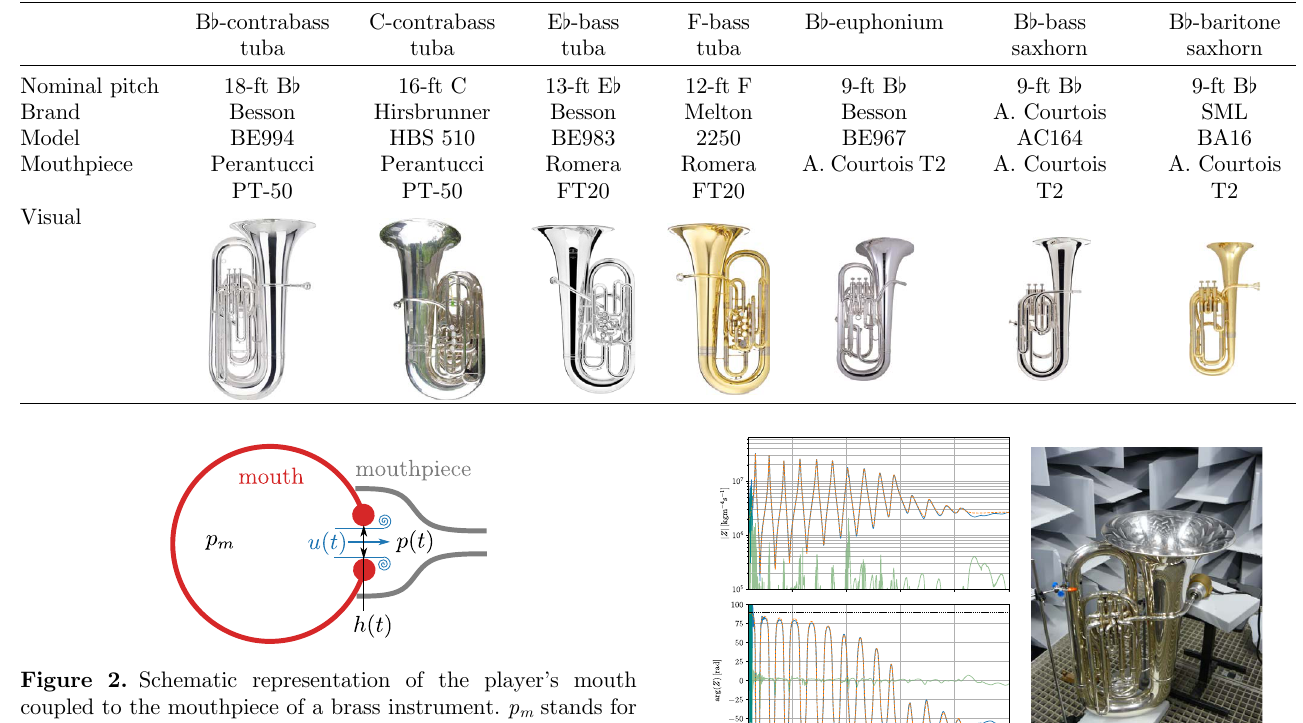
Table 1. Characteristics of the seven tubas studied in this paper, classi fi ed in the same order as in Figure 1. By convention, the nominal pitch speci fi es a number of feet (ft) coupled with a musical pitch name, being the nominal fundamental of the instrument (lowest note playable without any valve depressed). The number of feet corresponds to the equivalent cone length L ec fundamental by the formula L ec